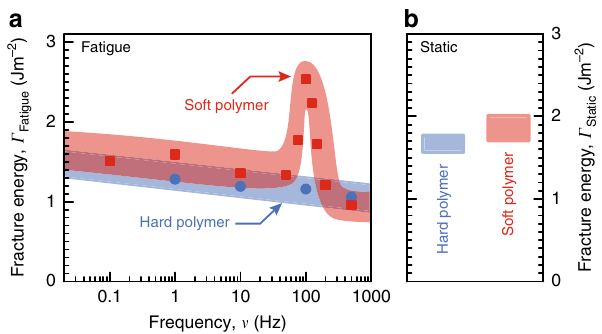
Fig. 4 Effect of polymer hardness on fatigue toughening. a Fatigue fracture energy Γ Fatigue and b Γ Static of polymer-metal-MPTMS-SiO 2 stacks with a soft System Three Resins ® T88 polymer (red squares), and a harder EPO- = 1.3 kPa. Each data point TEK 375 polymer (blue circles) at p H 2 O represents at least three tests. The width of the bands, drawn through the data points to guide the eye, connote the experimental uncertainties measured as